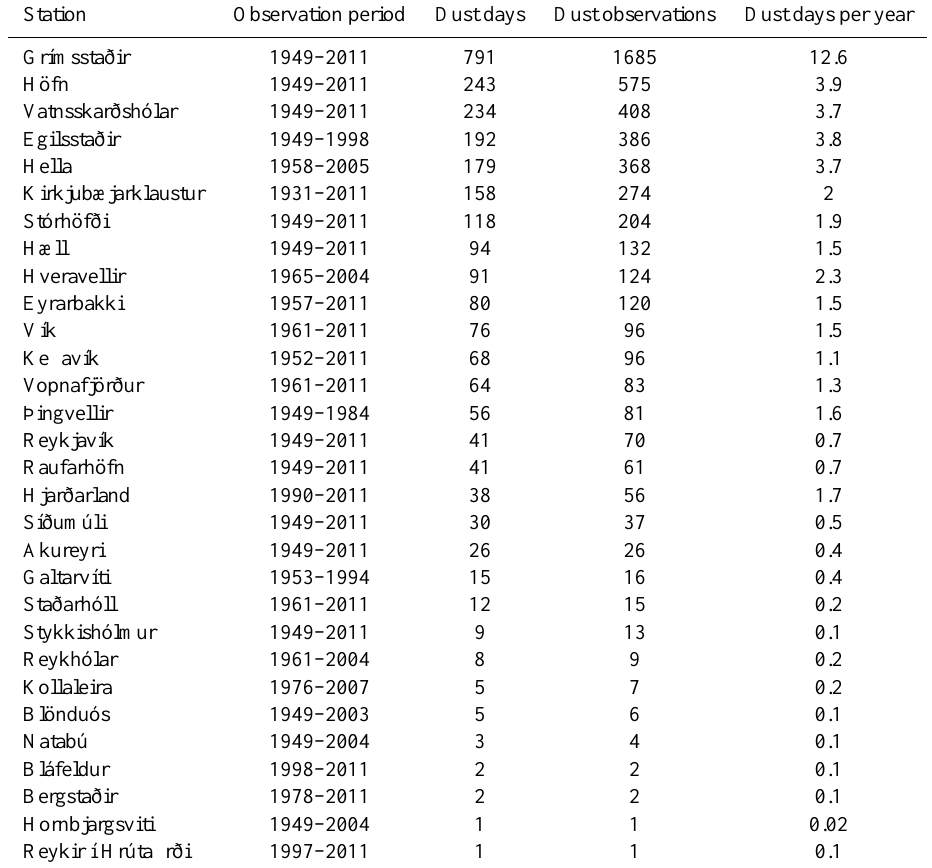
Table 1. Weather stations in Iceland reporting synoptic observations. Observation period, number of dust observations, dust days and dust days per year are included. Stations are listed in descending order of number of dust days.